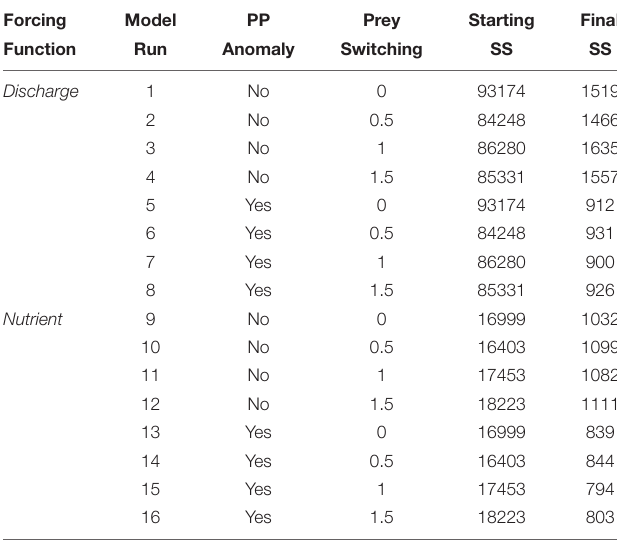
TABLE 2 | Series of fitted models that were implemented in